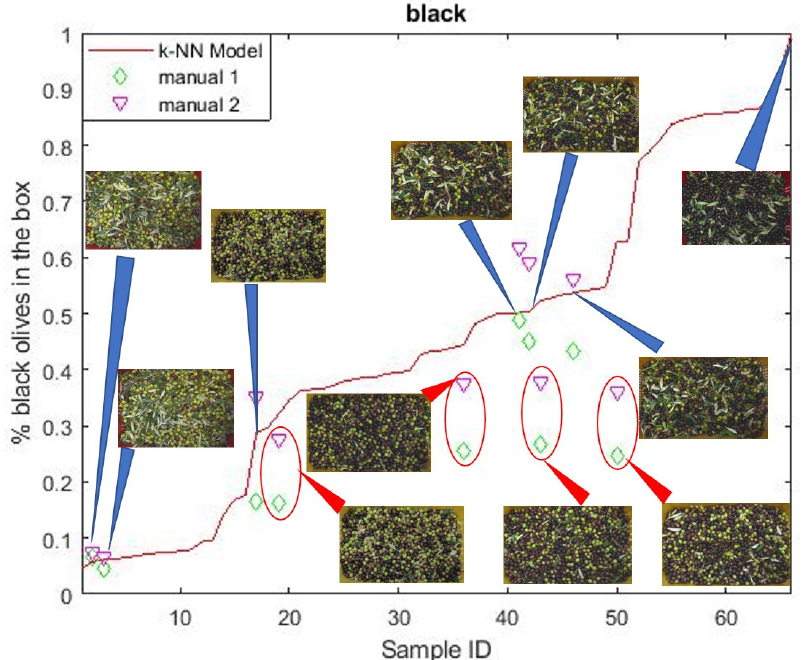
Figure 3. Comparison between the percentage of ripe (black) olives for each olive tray estimated by the counting algorithm (red line) and the percentage of ripe olives manually evaluated by two different operators: manual 1 (green diamonds) and manual 2 (purple triangles). The manual evaluation was performed on only 10 samples as a validation test of the counting algorithm. The percentage of black olives was overestimated for cleaner trays.